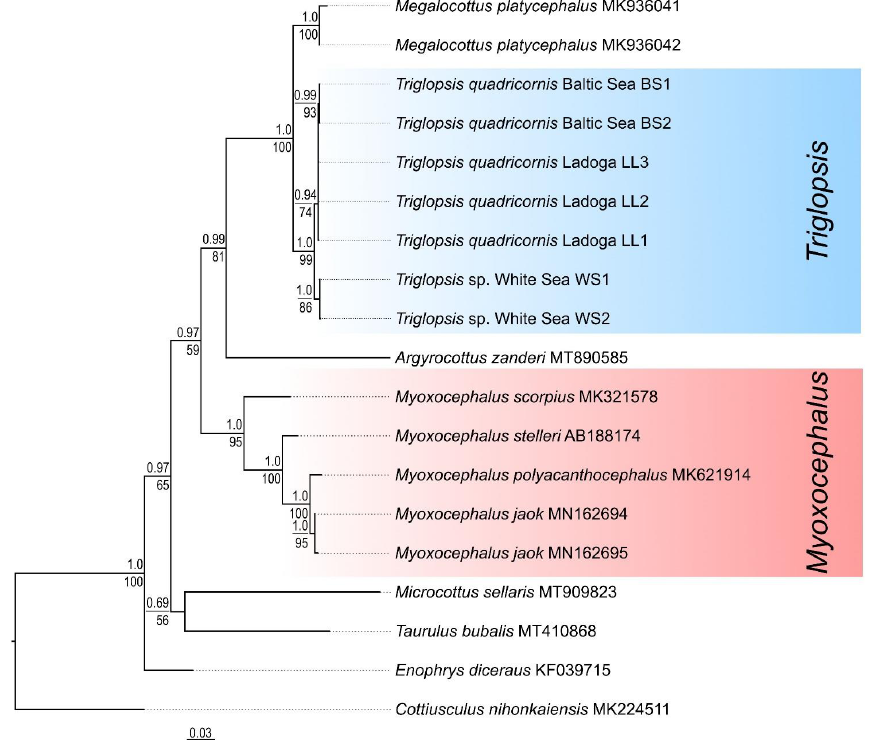
Figure 6. Bayesian phylogenetic tree of marine representatives of the subfamily Myoxocephalinae reconstructed using the sequences of the mtDNA CR . For each node, the posterior probabilities (upper number) and the bootstrap values obtained in the ML analysis (lower number) are indicated. The most basal position within the ingroup was occupied by Enophrys diceraus , which lives in the northern part of the Pacific Ocean and the adjacent Arctic. On the CR tree (Figure 6), the clades corresponding to the two genera ( Triglopsis and Myoxocephalus ) were well isolated from each other and had very high supports. Clusters of T. quadricornis (Bal- tic and Ladoga haplotypes) and White Sea Triglopsis sp. were well supported on the CR tree.